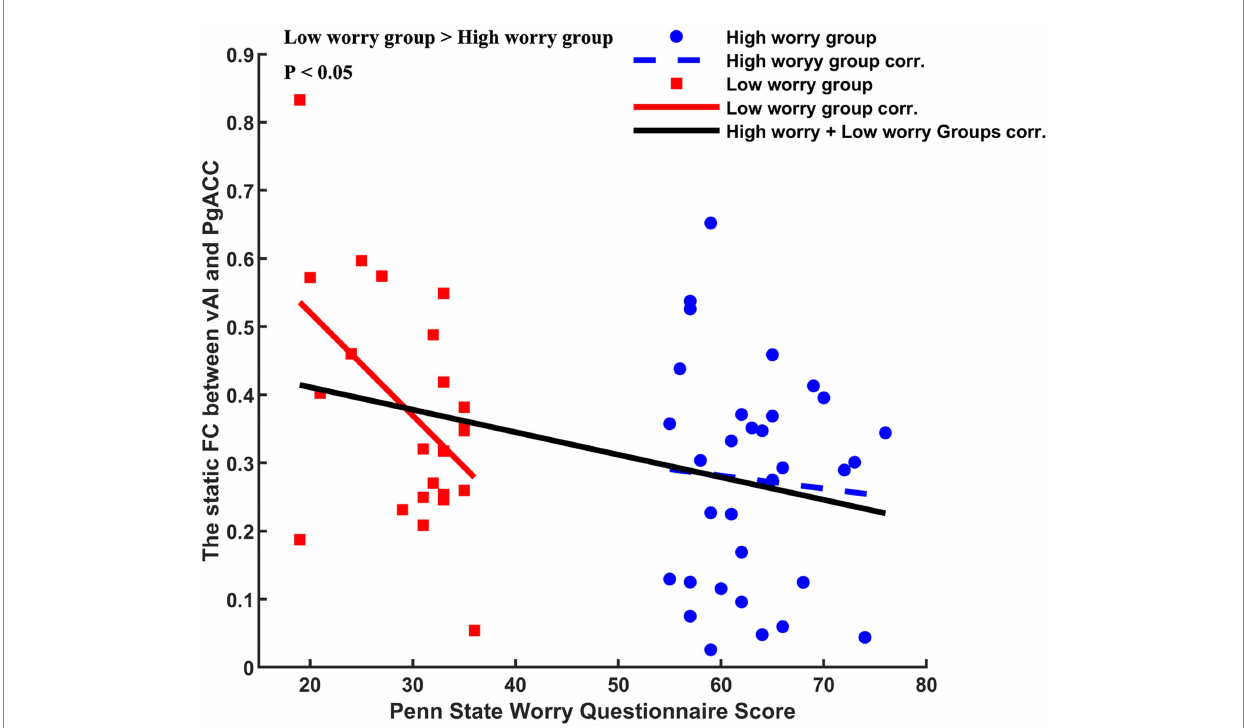
FIGURE 4 Different correlations between Penn State Worry Questionnaire (PSWQ) score and altered static left vAL-PgACC (pregenual anterior cingulate cortex). Negative relationship ( r = − 0.5000, p = 0.0109) was found in the low worry-proneness group (red node and line), whereas this correlation ( r = − 0.0677, p = 0.7127) was not apparent in the high worry-proneness group (blue node and line). The difference between these two correlation coefficients was significant ( p <